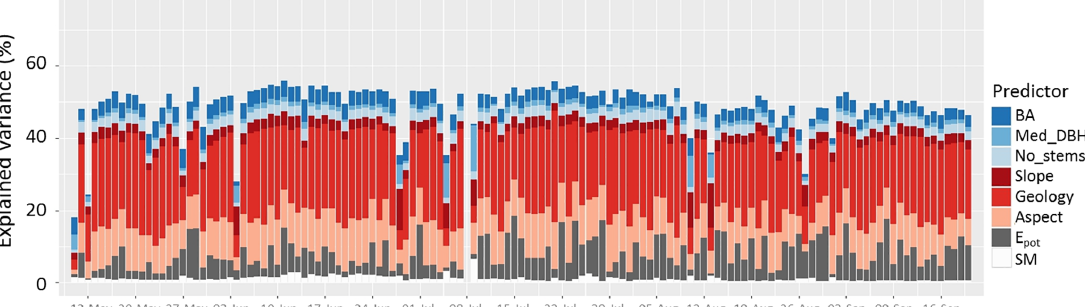
Figure 8. Proportion of variance explained by the different predictors in the daily linear models of spatial sap flow patterns: 132 daily models from 61 trees at 24 sites.